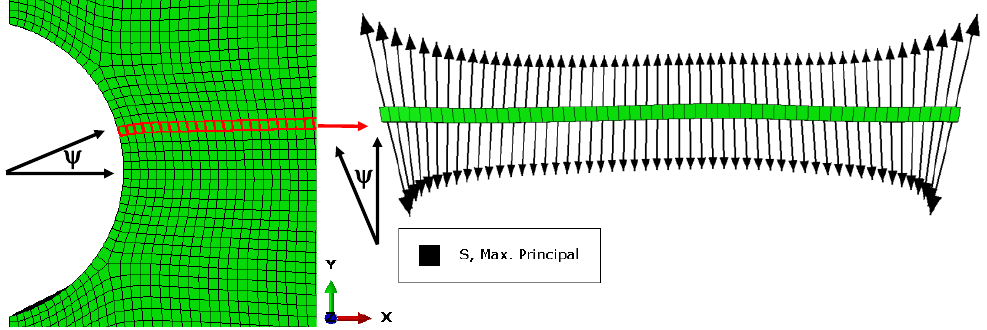
Figure 18. Cross section of elements through the notch with directions of principle stress.